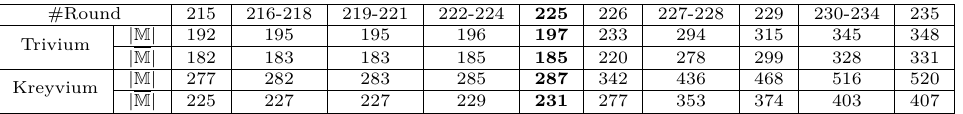
Table 2: The number of monomials in the output bit and its maximal polynomial of Trivium and Kreyvium with round from 215 to